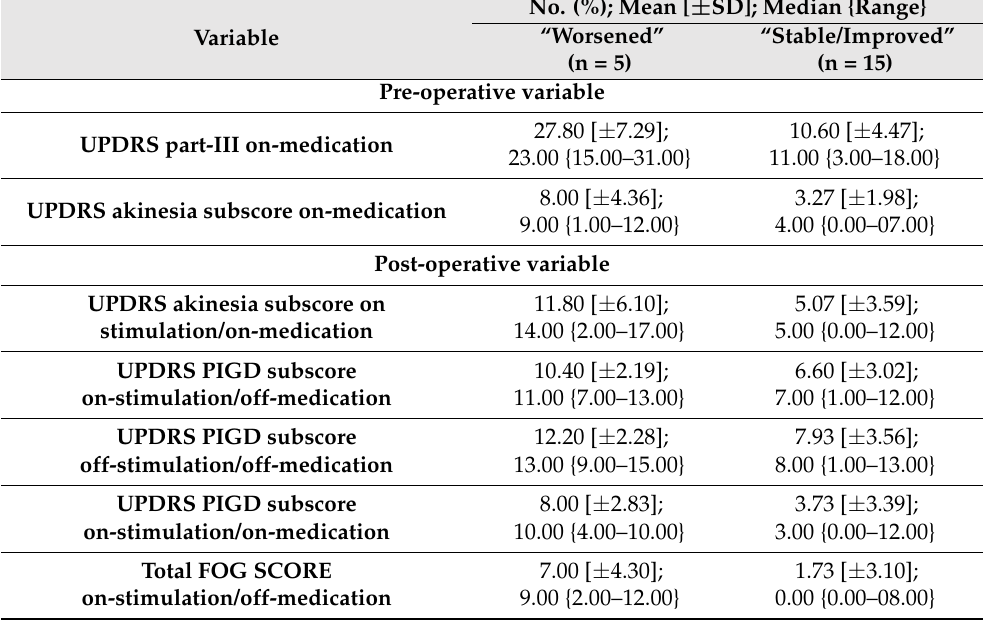
Table A5. Clinical characteristics between the “worsened” and “stable/improved”